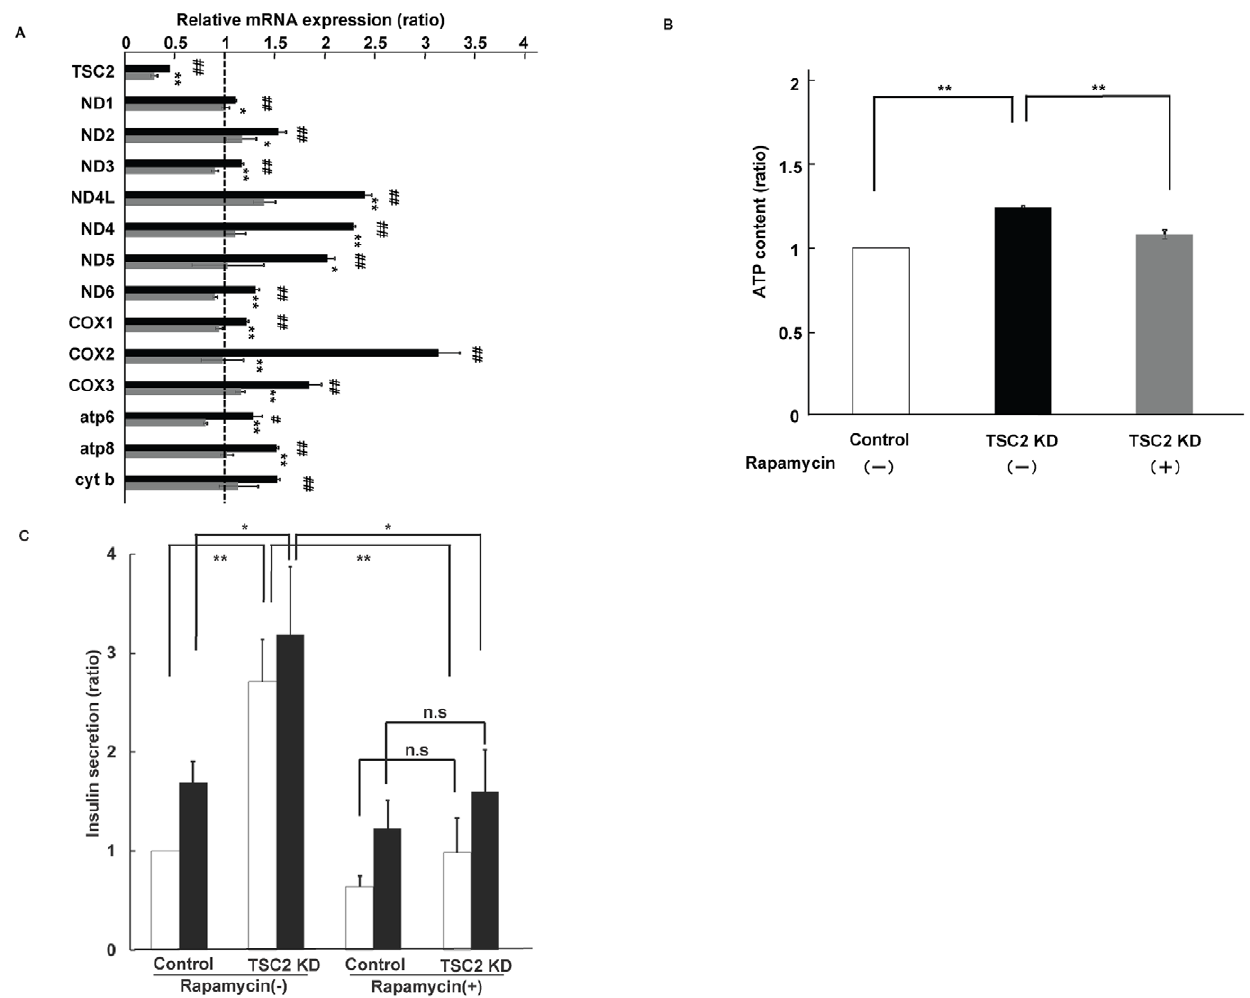
Figure 5. Effects of rapamycin treatment on mitochondrial function in TSC2 INS-1 cells. ( A ) Effect of rapamycin treatment on mitochondrial DNA expression. The ratio of TSC2 INS-1 cells untreated (black bar) and treated (grey bar) with 20 nM rapamycin to control cells. Data are means 6 SE of triplicate pooled total RNA samples from three independent experiments. # P , 0.05; ## P , 0.01 TSC2 cells compared with control (vehicle) cells. * P , 0.05; ** P , 0.01 TSC2 cells treated with rapamycin compared with TSC2 INS-1 cells treated with vehicle. ( B ) Analysis of rapamycin effect on ATP production. ATP content of control cells (open bar), TSC2 INS-1 cells treated with (grey bar) and without (lack bar) 20 nM rapamycin ( n =12) Figure shows data from one representative of two independent experiments. ( C ) Insulin secretion in response to 2.8 mM (open bar) and 25 mM (filled bar) glucose for 30 min was assessed in INS-1 cells and expressed per DNA content. Data are shown with and without 20 nM rapamycin ( n =6). Figure shows data from one representative of three independent